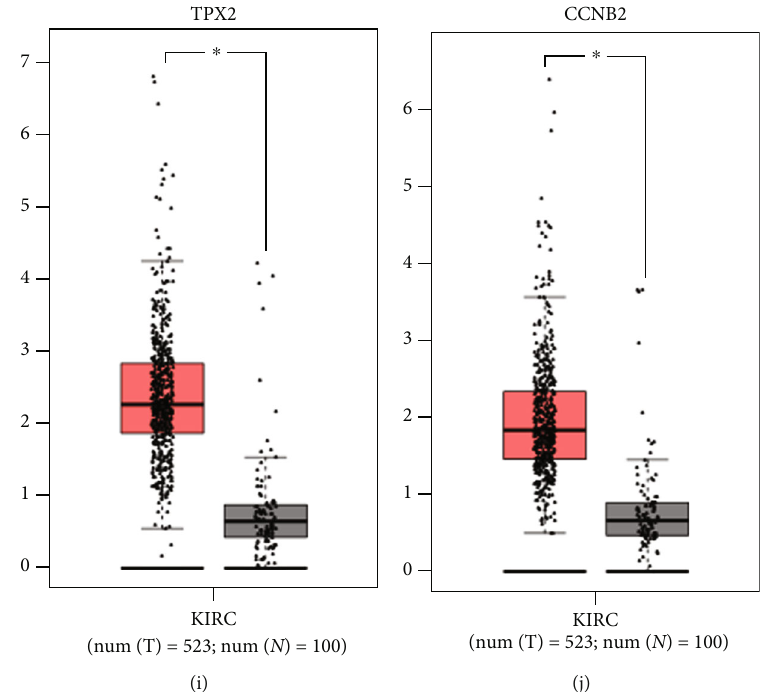
Figure 6: Key gene expression analysis in MEblack, MEyellow, MEgreen, and MEmagenta modules. (a) KIF20A, (b) UBE2C, (c) CCNA2, (d) TOP2A, (e) PLK1, (f) RRM2, (g) CDC20, (h) AURKB, (i) TPX2, and (j) CCNB2. Red: KIRC group; gray: normal